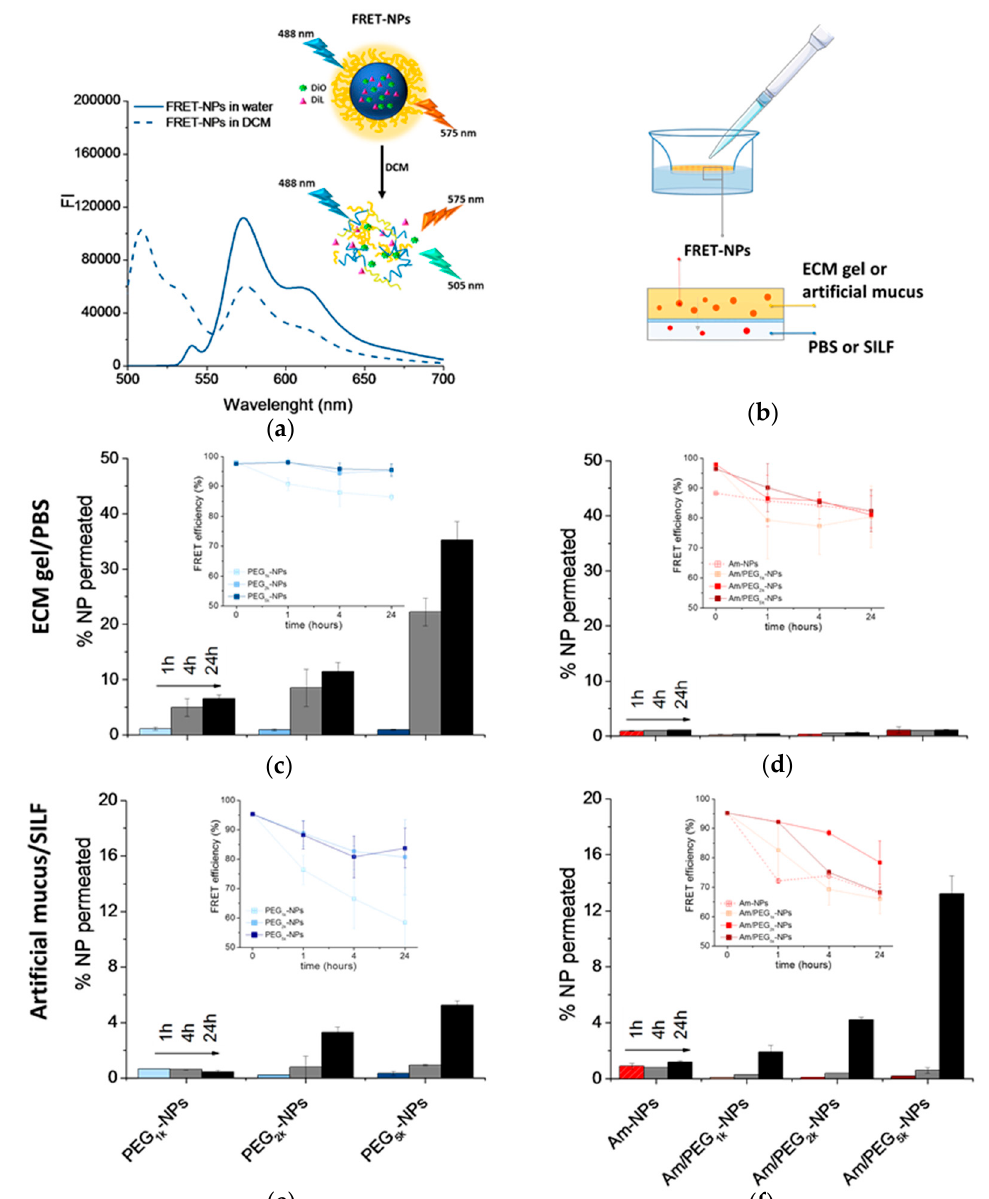
Figure 6. Permeation of NPs through protein-rich gels over time. For this experiment, NPs were loaded with DiO/DiL as a FRET pair. ( a ) Emission spectra collected after DiO excitation ( λ ex = 488 nm) of DiO/DiL-loaded PEG 5k- NPs dispersed in water or dissolved in DCM. ( b ) Set-up of the transport experiment. Amount of DiO/DiL-loaded PEG-NPs ( c , e ) and amine-NPs and amine/PEG-NPs ( d , f ) found in the acceptor chamber after crossing the ECM gel ( c , d ) and artificial mucus ( e , f ). The amount of NPs in the acceptor medium was evaluated by monitoring DiL emission ( λ ex = 543 nm). In the inset, FRET efficiency is reported (for the calculation, see Section 2.7). Data are an average of triplicate measurements ± SD.